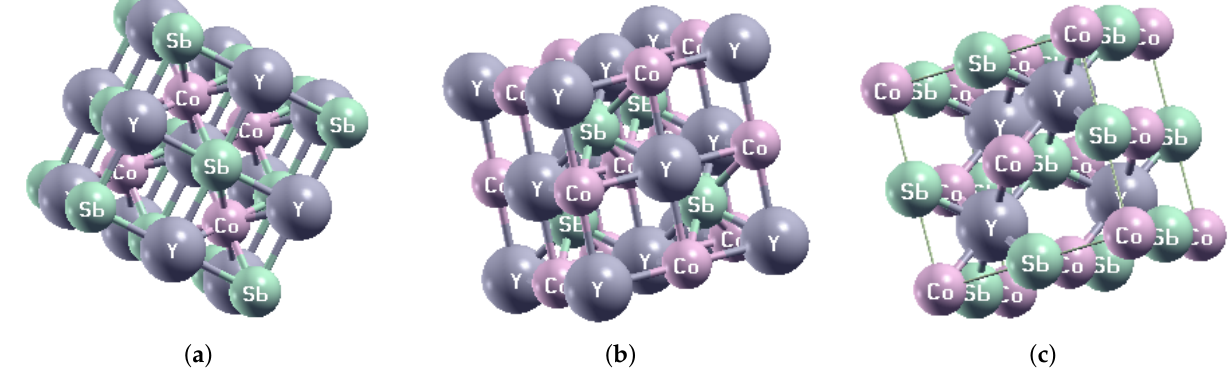
Figure 1. The optimized crystal structure of CoYSb (Y = Cr, Mo, and W) for ( a ) Type-I, ( b ) Type-II, and ( c )